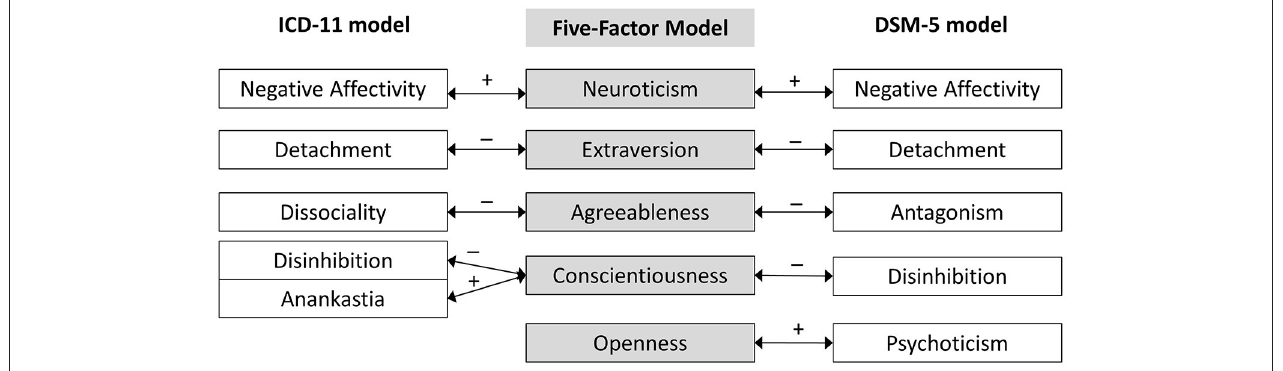
FIGURE 1 | Juxtaposition of the ICD-11 and DSM-5 models of pathological Big Five domains with the FFM model of normal personality structure.